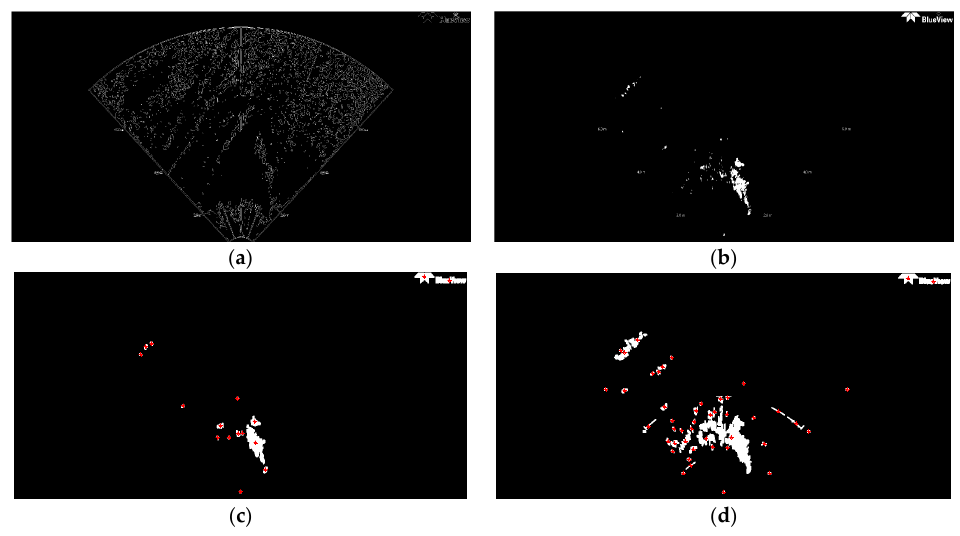
Figure 10. ( a ) Canny edge detection after employing the traditional Otsu method, bw = edge (b, ‘canny’, 0.13), N 40 = 1341 > 600; ( b ) Improved Otsu TSM, T = 0.1176, T * = 0.5412; ( c ) Result of the improved Otsu TSM after morphological operations marking the centroids of the acquired areas; ( d ) Result of the maximum entropy TSM after the same morphological operations marking the centroids of the obtained regions.